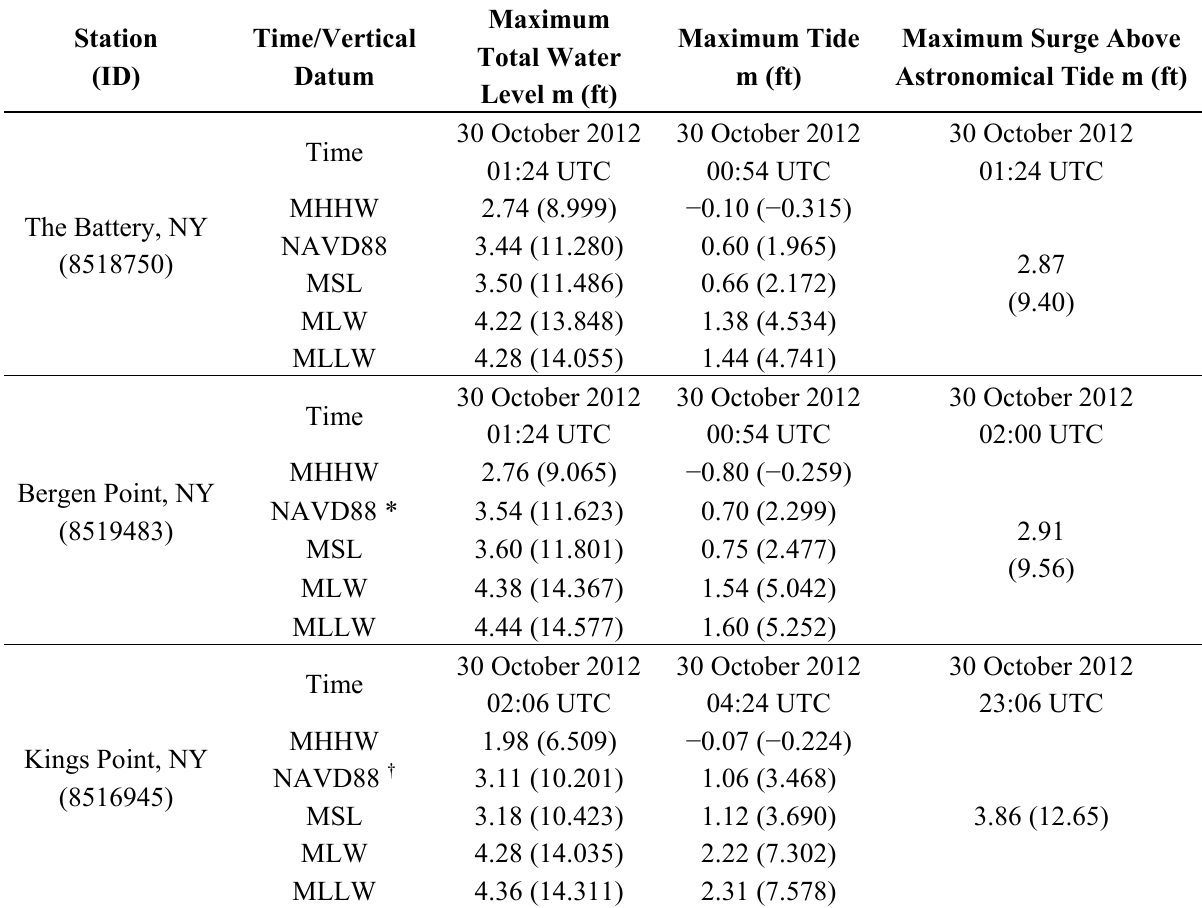
Table 1. Maximum total, tide (referenced to various vertical datums) and surge water levels reached at three NOAA tide gauge stations at the coast: The Battery, Bergen Point and Kings Point, NY (see Figure 2 for station